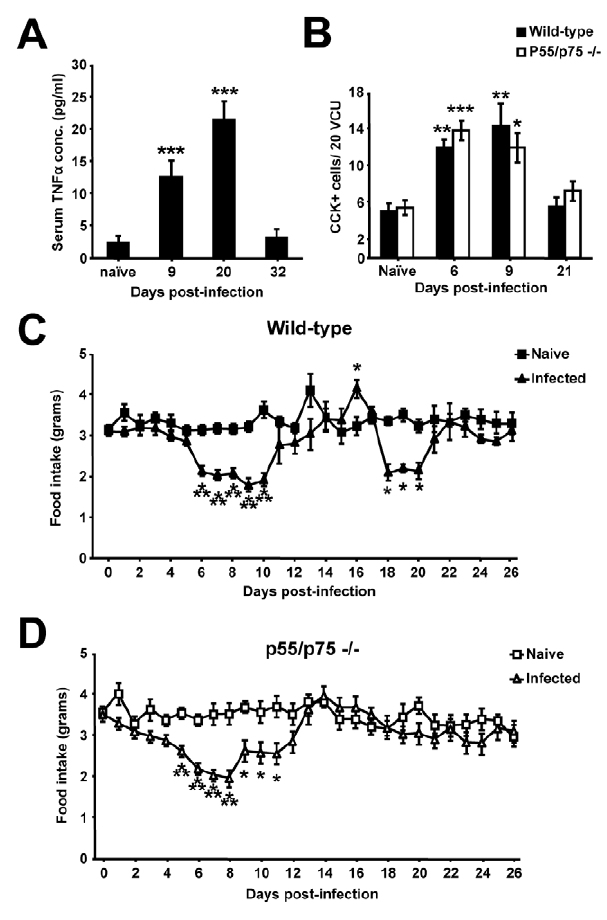
Figure 3. Secondary hypophagia during T. spiralis induced peripheral inflammation is absent in p55/p75 2 / 2 mice. ( A ) TNF a serum levels during infection in wild-type mice determined via cytometric bead array ( B ) Number of CCK positive cells/20 VCU, as determined from immunohistochemistry in wild-type and p55/p75 2 / 2 mice. Food intake of naı¨ve and infected wild-type ( C ) and p55/p75 2 / 2 ( D ) mice, derived via weighing chow daily. Data (n=7–16 mice per group) are from three independent experiments. *, P , 0.05; **, P , 0.01; or ***, P , 0.005 between naı¨ve and infected groups, error bars represent SE of